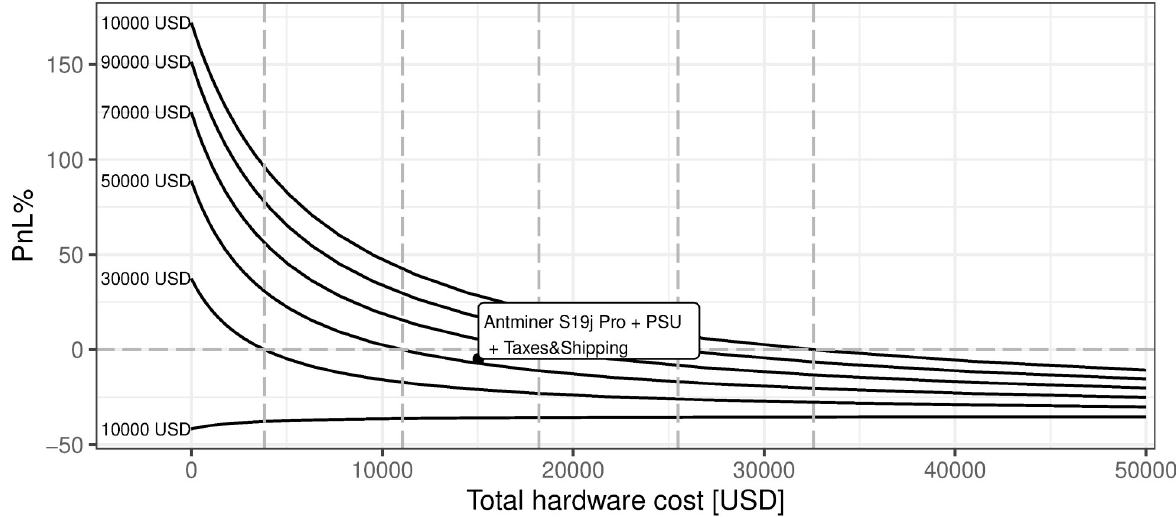
Fig 27. BTC mining profitability (PnL%) for different levels of hardware cost and BTCUSD price. Note: PnL%, calculated according to the formula 6. Hypothetical hardware cost per unit ranges from 0 USD up to 50000 USD and BTCUSD price ranges from 10000 USD up to 110000 USD. Antminer S19J Pro is assumed as the most optimal mining machine and its point describes the current state of market mining efficiency assuming parameters outlined in section Values of variables as of 2021/12/03. Source: own calculations based on data described in section Crucial assumptions and